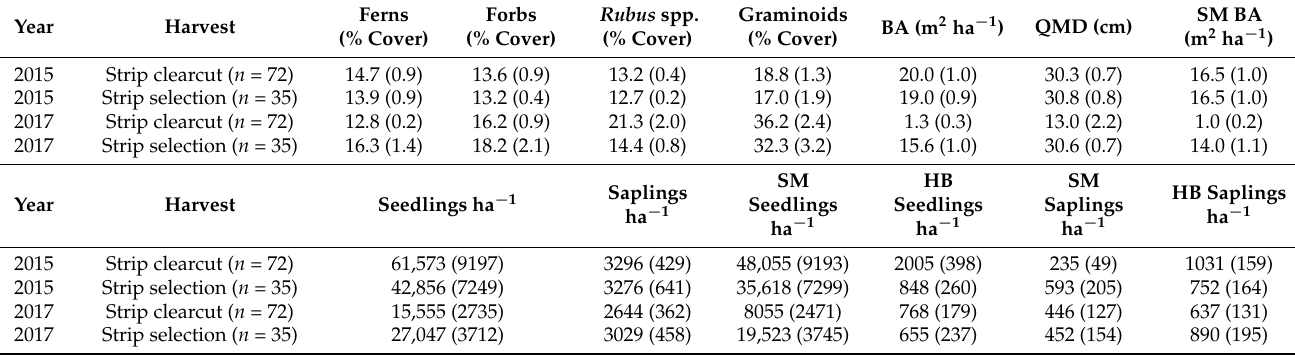
Table 1. Average ( ± SE) stand characteristics pre- and post-harvest in a managed northern hardwood forest in the Upper Peninsula of Michigan, USA. Saplings were defined as ≥ 45.7 cm (18 inches) tall but <15.4 cm (6 inches) diameter at breast height. Seedlings were defined as <45.7 cm tall. Trees were counted for basal area if the diameter at breast height was >15.4 cm. BA, basal area; QMD, quadratic mean diameter; BA, basal area; SM, sugar maple; HB,